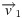
Spatiotemporal ERFs for a sample cell stimulated at 30 Hz.A) Three excitatory components were observed for this cell. Two components occurred in the same stimulus frame but were spatially different (v→1 and v→2). The other occurred in a different stimulus frame (v→3). B) Two suppressive components were observed for this cell. The components were spatially similar to v→1 and to each other but had different temporal characteristics. Although longer temporal windows were explored, only lags where significant electrodes occurred are shown. Stars denote electrodes that significantly affected the neuron’s response. Significance was calculated by a nested-bootstrap method (see Methods) at the 95% confidence level.